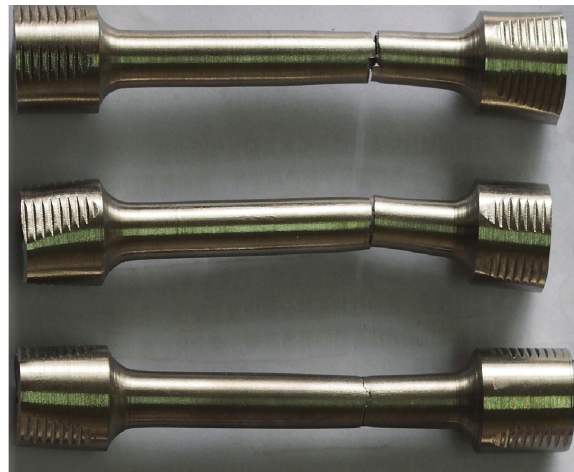
Figure 8: Fractured specimens.